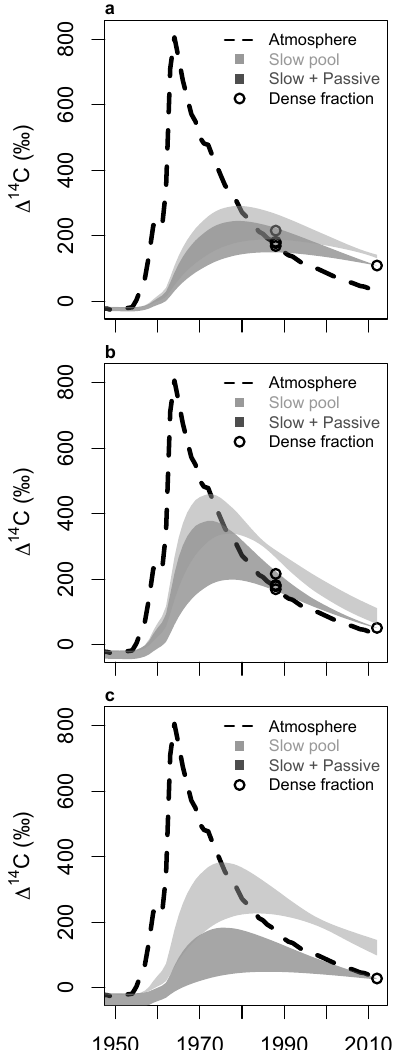
Figure 1. Modeled soil (cid:49) 14 C over time for the slow pool (light- grey shading) and the slow + passive pools (dark-grey shading) of mineral-associated C. The dashed line shows atmospheric (cid:49) 14 C for zone 2 of the Northern Hemisphere. Shaded regions represent 95% confidence intervals for (cid:49) 14 C of a given soil sample calculated us- ing Monte Carlo methods that varied 1988 (cid:49) 14 C and turnover time of passive C. Panels (a) and (b) show trends for individual sam- ples where 2012 (cid:49) 14 C = 109.4 and 51.0‰, respectively, in 2012, along with four samples from 1988. Panel (c) shows trends for a sample where 2012 (cid:49) 14 C = 28.5‰ ; this and four other samples with (cid:49) 14 C less than the 2012 atmosphere could not be realistically constrained by 1988 surface soil (cid:49) 14 C due to a greater abundance of passive C (see Sect. 2.4 for details on how these samples were